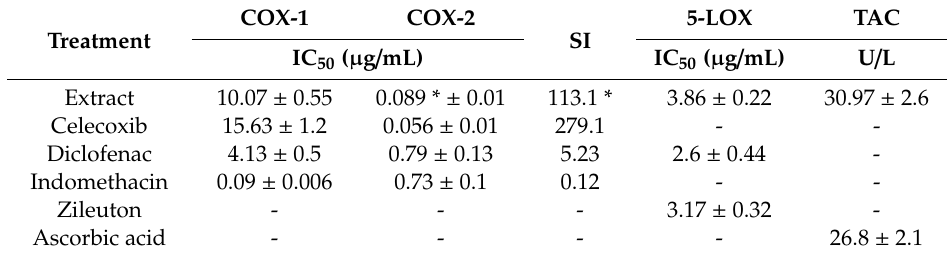
Table 2. In vitro cyclooxygenase-1 (COX-1), cyclooxygenase-2 (COX-2) and lipoxygenase (LOX) inhibition (IC 50 ) and the total antioxidant capacity (U / L) of the S. tetrasperma